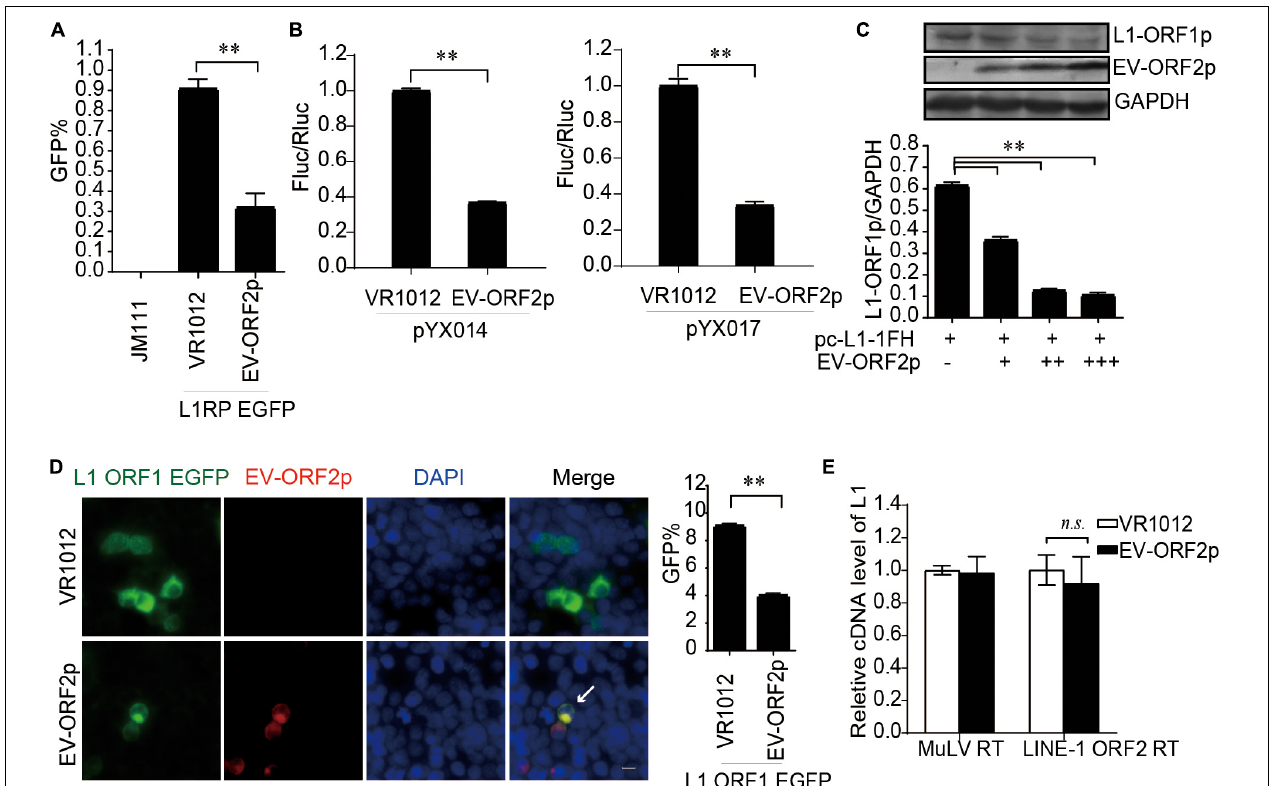
FIGURE 6 | EV-ORF2p inhibited LINE-1 retrotransposition activity. (A) L1RP EGFP and VR1012/VR1012-EV-ORF2 plasmids were co-transfected into HEK 293T cells. Flow cytometry was performed after 4 days. The bar graph depicts the M ± SD of each experiment, performed in triplicate. The asterisks indicate statistically significant differences between groups by unpaired Student’s t -test ( p < 0.01). (B) pYX014 or pYX017 constructs were transfected with VR1012 or VR1012-EV-ORF2p. The dual-luciferase assay was performed after 4 days. The VR1012 group was set to 1.0. The asterisks indicate statistically significant differences between groups by unpaired Student’s t -test ( p < 0.01). (C) VR1012 or VR1012-EV-ORF2 plasmids (250, 300, and 350 ng) were co-transfected with pc-L1-1FH (250 ng). Cells were harvested after 48 h, and then immunoblotting was performed. (D) pEGFP-N1-ORF1-EGFP and VR1012/VR1012-EV-ORF2 plasmids were co-transfected. Immunostaining and fluorescence imaging were performed as described in the “Materials and Methods” 48 h post-transfection: scale bar, 20 µ m. Bar graph represents the percentage of GFP-positive cells from flowcytometry. Data are represented as the mean ± SD, and the asterisks indicate statistically significant differences between groups by Unpaired Student’s t -test ( p < 0.01). (E) LEAP assay and quantitative real-time PCR were performed as described in the “Materials and Methods” section. The bar graph of relative cDNA level of L1 represents reverse transcription efficiency of L1 ORF2p or MuLV. The relative cDNA level of MuLV RT was set to 1.0. The asterisks indicate statistically significant differences between groups by Unpaired Student’s t -test ( p <